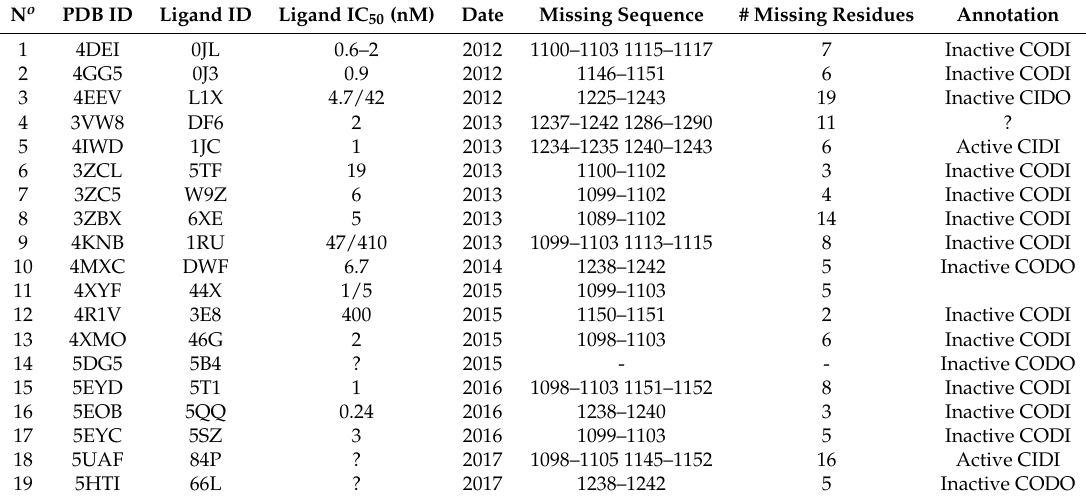
Table 3. List of the PDB MET kinase domain structures added to the ones coming from our previous work [22]. The kinase conformation associated to each structure is annotated according to the KinaMetrix web resource [56]: DO means DFG-out, DI means DFG-in, CO means α -cHelix-out, CI means α -cHelix-in, and ω CD indicates DFG